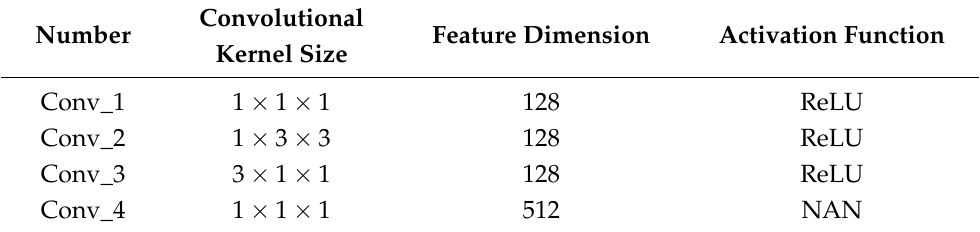
Table 2. Specific parameter configuration of convolutional layer of the 3D residual structure.